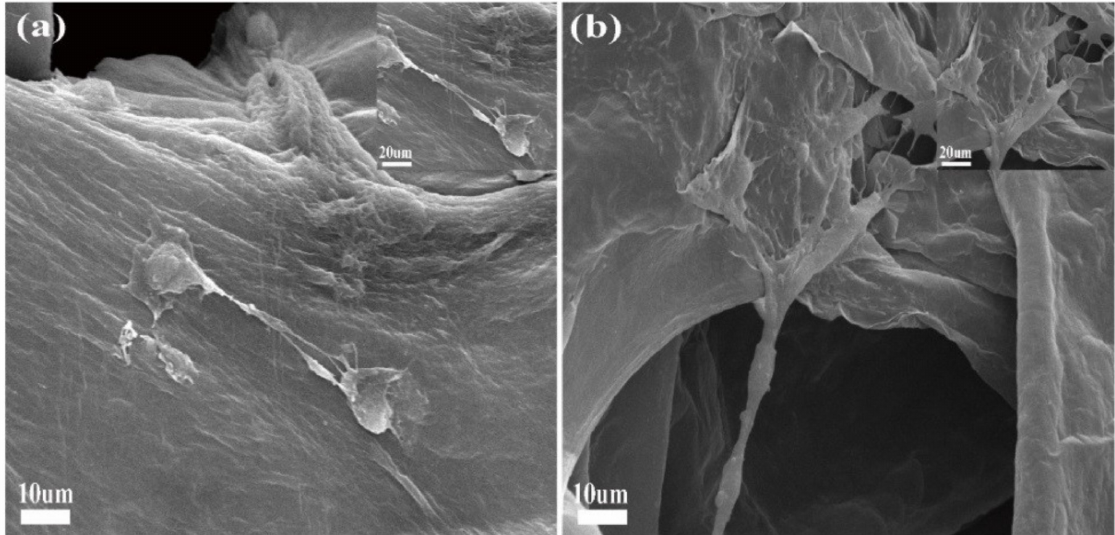
Figure 6. SEM images of MC3T3-E1 on the surfaces of 3D rGO/PPY/Sr scaffolds at 48 ( a ) and 96 h ( b ),